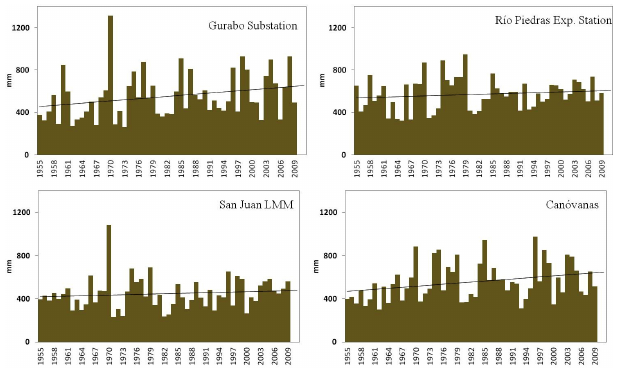
Table 4 . Seasonal trends. Mann-Kendall